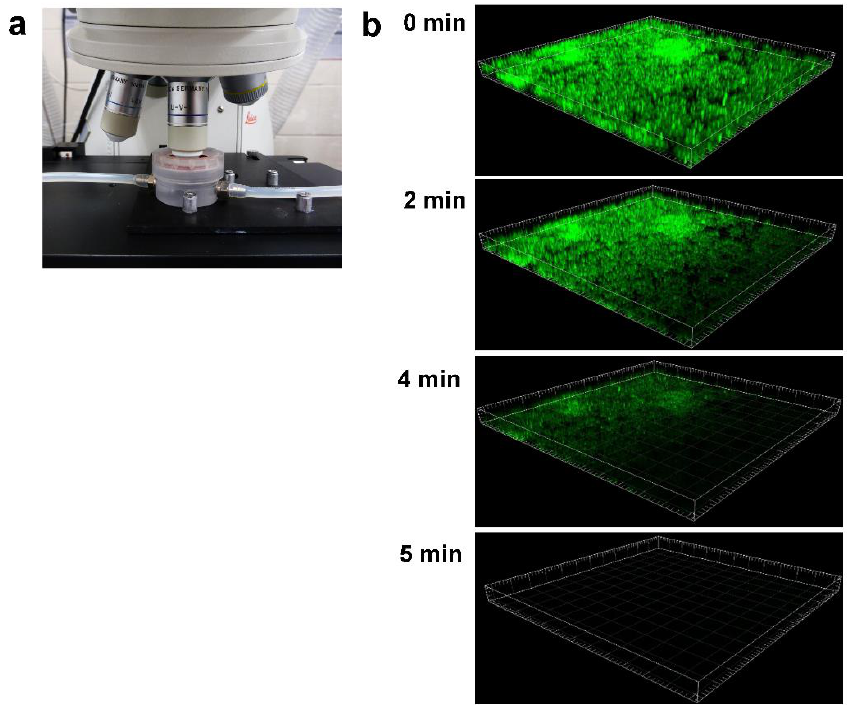
Figure 6. ( a ) Treatment imaging flow cell (FC) under CLSM for time lapse experiments; ( b ) time lapse CLSM of ethanol action performed on E. coli biofilm grown on low density polyethylene surfaces functionalized with p -aminosalicylic acid. The fluorescence loss from stained E. coli cells is used to monitor real-time loss in cell viability during the biocide action. Under ethanol treatment, biofilm displayed a total loss in fluorescent intensity in 5 min.